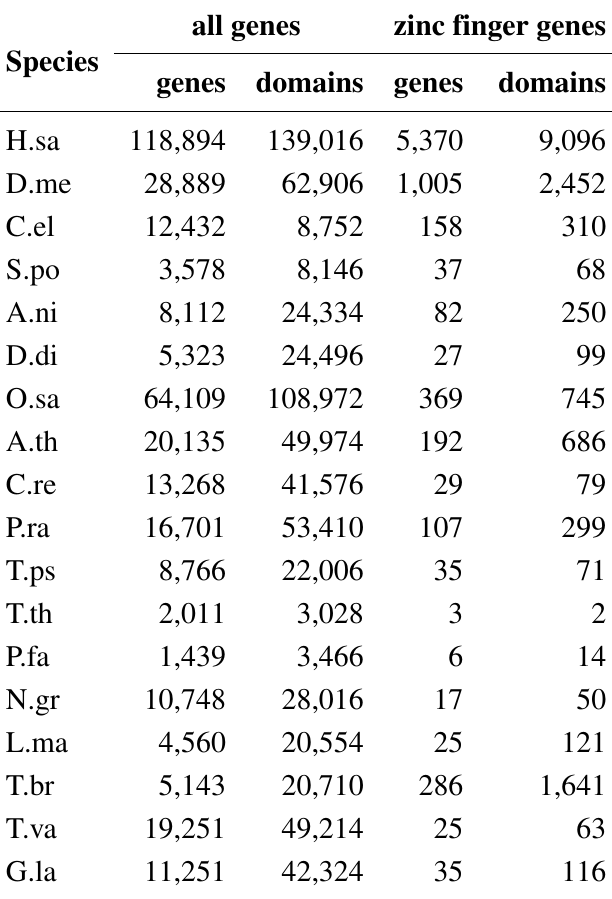
Table 1. Summary of gene and domain